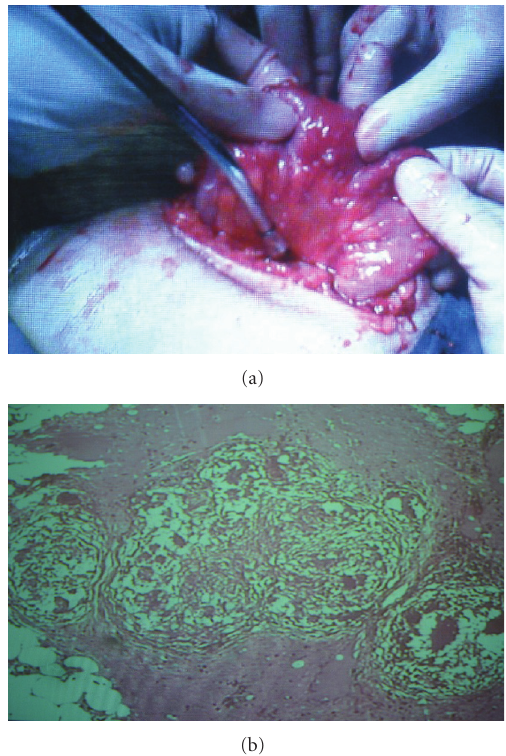
Figure 3: (a) Miliary pattern all over the abdominopelvic organs (Case 3), (b) Microscopic picture showing chronic granulomatous inflammation with epitheloid histiocytes and Langhans type multi- nucleated giant cells (Case